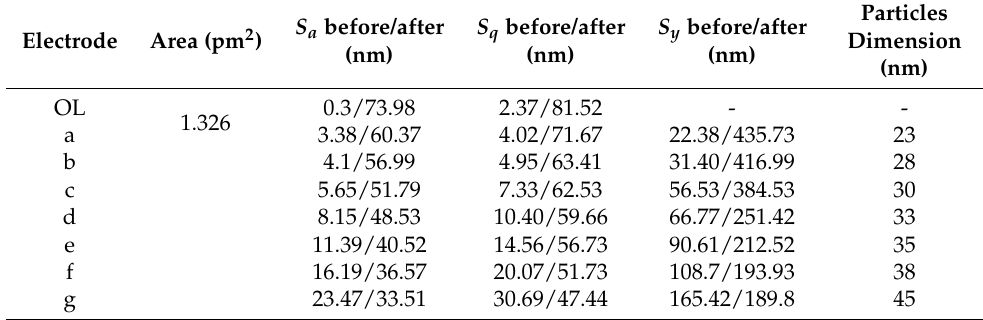
Table 2. Surface particle dimensions and the